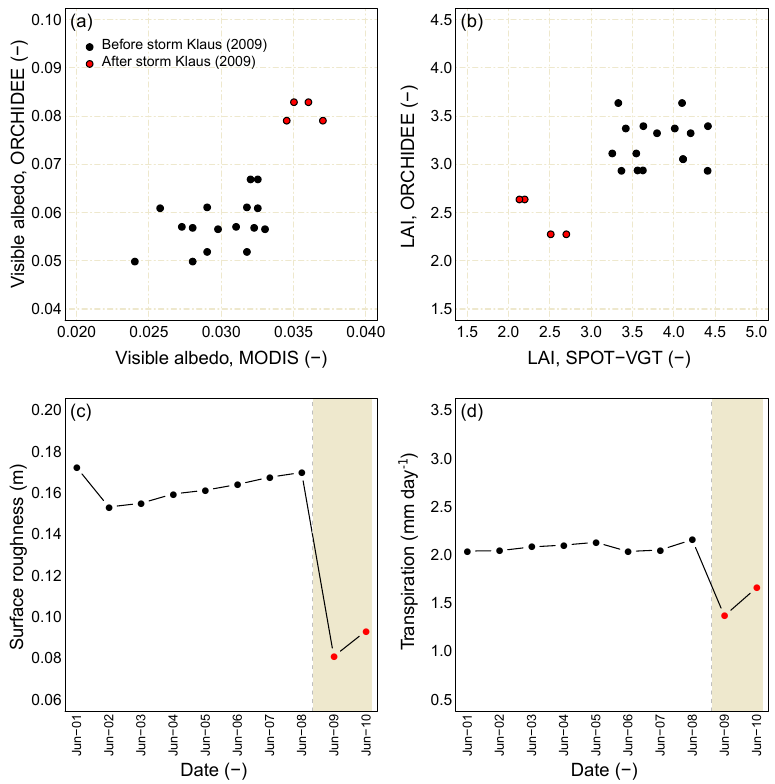
Figure 9. Effects of the wind storm Klaus (January 2009) on the forest in Les Landes, France. Comparison of the ORCHIDEE-CAN- simulated visible albedo and the MODIS observations in summertime (June) from 2001 to 2010 (a) . Comparison of the ORCHIDEE-CAN- simulated leaf area index (LAI) and SPOT-VGT-derived estimates in summertime (June) from 2001 to 2010 (b) . The dynamics of roughness for the most damaged pixel in Les Landes forest simulated by ORCHIDEE-CAN on a monthly timescale from 2001 to 2010 (c) . The summertime (June) transpiration rate for the most damaged pixel in Les Landes forest simulated by ORCHIDEE-CAN (d) . The shading indicates the period after the passing of Klaus in January